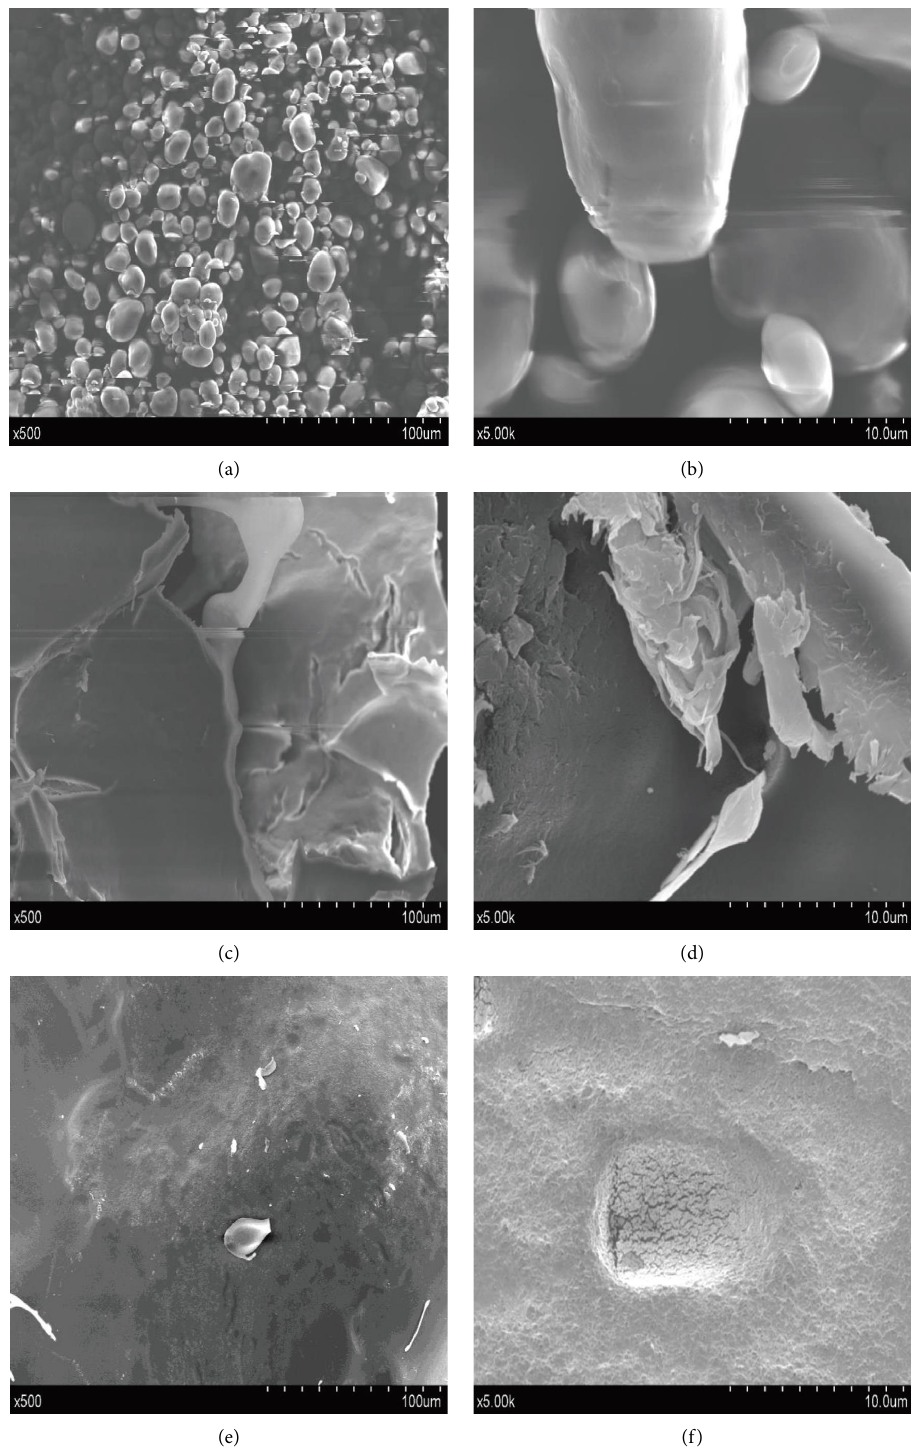
Figure 2: Morphological changes in arrowhead starch (a), (b), RS3-E (c), (d), RS3-UAE (e), and (f) (magnifcation: 500x and 5000x). RS3-E type 3 resistant starch prepared by traditional-enzymolysis; RS3-UAE type 3 resistant starch prepared by ultrasound-assisted